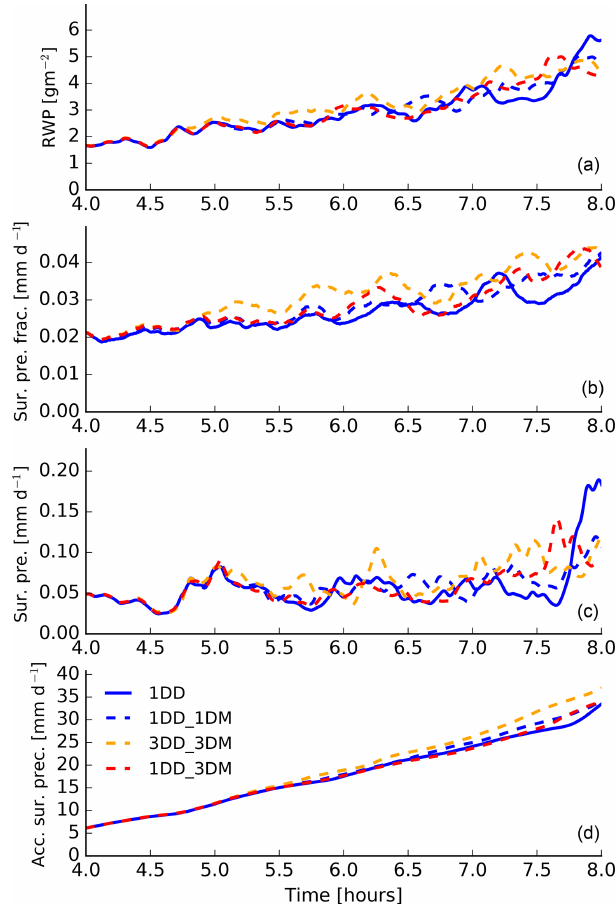
Figure 15. Temporal development of rain water path (a) , surface precipitation fraction (b) , domain-averaged surface precipitation rate (c) and the accumulated domain-averaged surface precipitation rate (d) . The time series is shown from the restart time of 4h on- ward. We compare four of our five simulations here where thermal radiation was coupled to the diffusional droplet